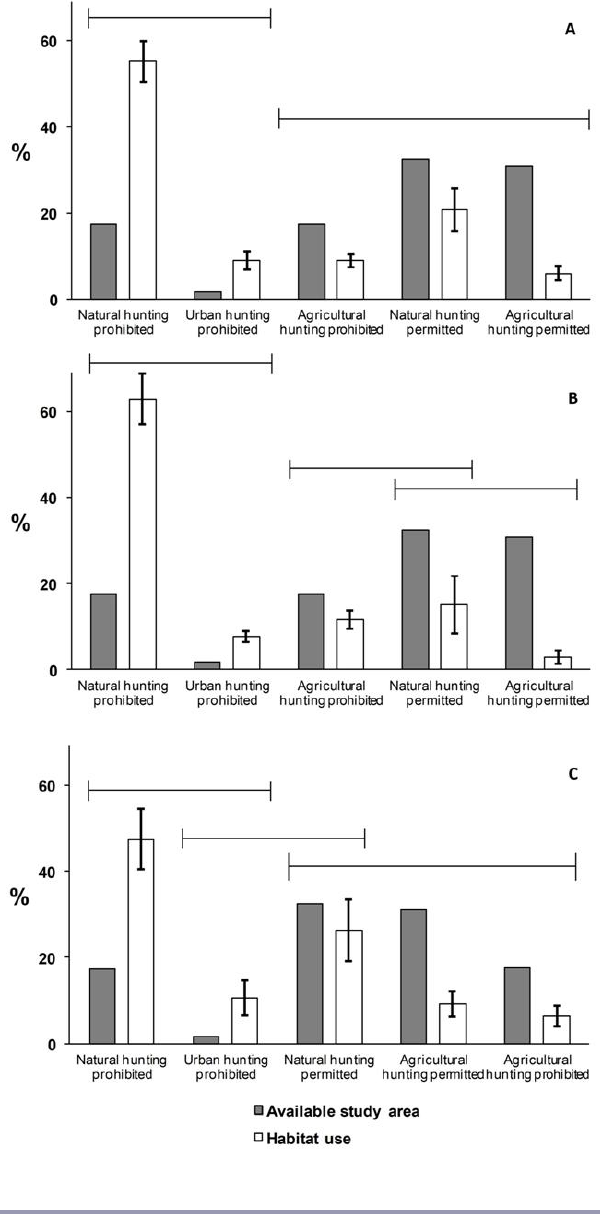
Fig. 4 . Mean (±1 SE) % locations of radio-collared Canada Geese ( Branta canadensis maxima ) in different habitats during the hunting season near Montréal, Québec in 2004 for A) all radio-collared birds (n = 24), B) attending females (n = 12), and C) nonattending females (n = 12). Habitat availability is the % of the surface area. Habitats are ranked from left to right in terms of selection and nonsignificant differences among habitats are indicated by a connected line (P > 0.05, compositional